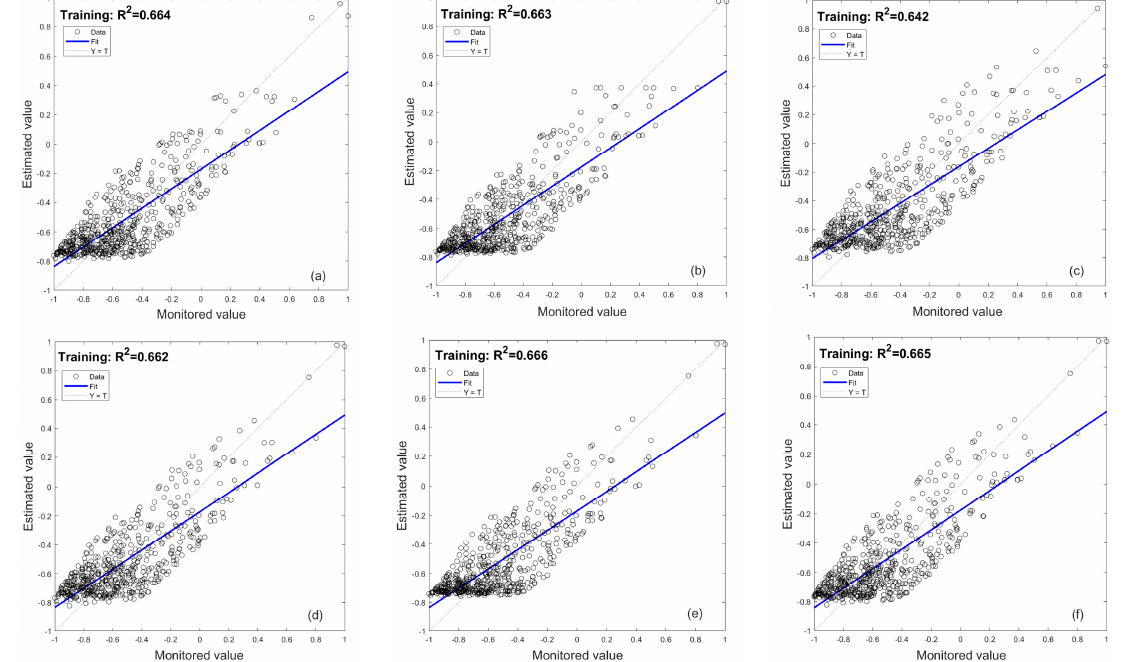
Remote Sens. 2022 , 14 , x FOR PEER REVIEW Figure 8. Estimated results of AOD–PM 2.5 BPNN training set ( a ) –( f ). Figure 8. Estimated results of AOD–PM 2.5 BPNN training set ( a – f ).